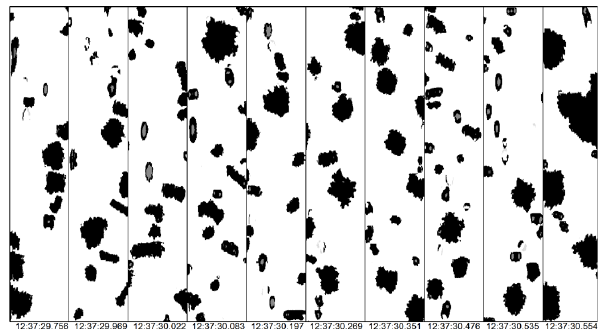
Fig. 11d. As Fig. 11a. Data are from R5 ( T =− 4 . 3 ◦ C, altitude = 2.57km) in the region of convective cloud encountered ap- proximately 20km west of